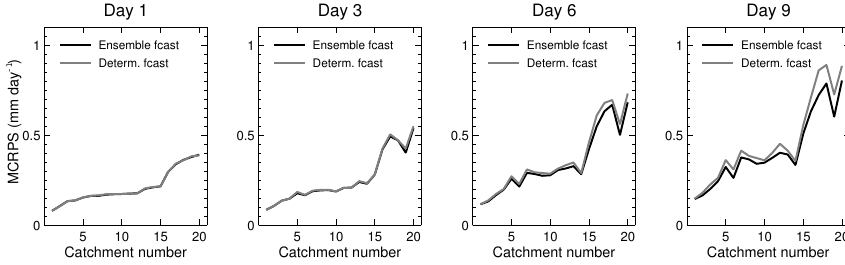
Figure 8. Comparison of EnKF multimodel MCRPS with deterministic and ensemble meteorological forcing (system G vs. H).